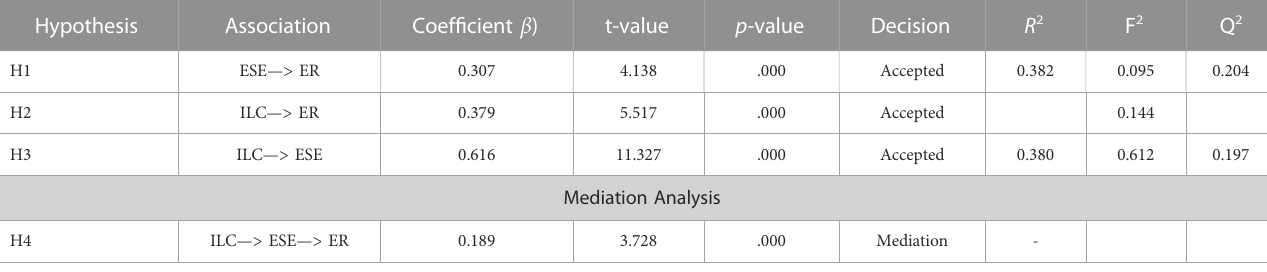
Path analysis. Source: Primary Data.